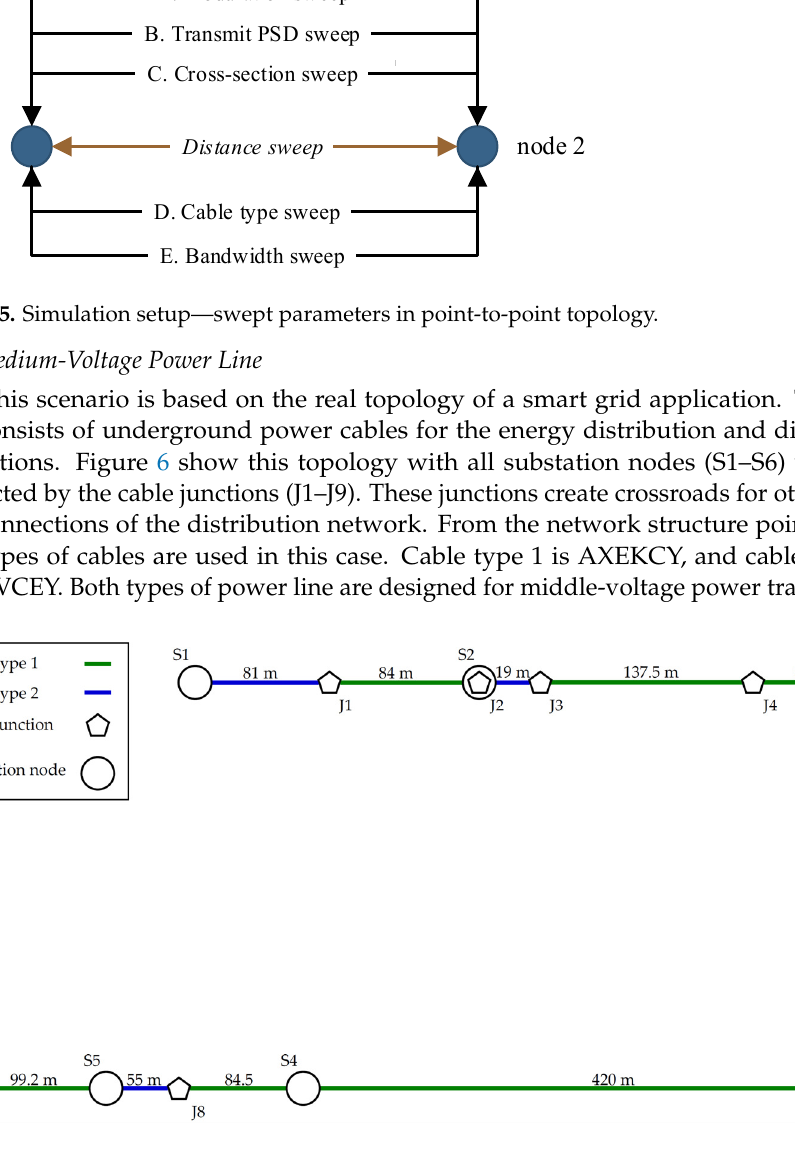
Figure 6. Diagram of real MV power lines with BPLC communication.